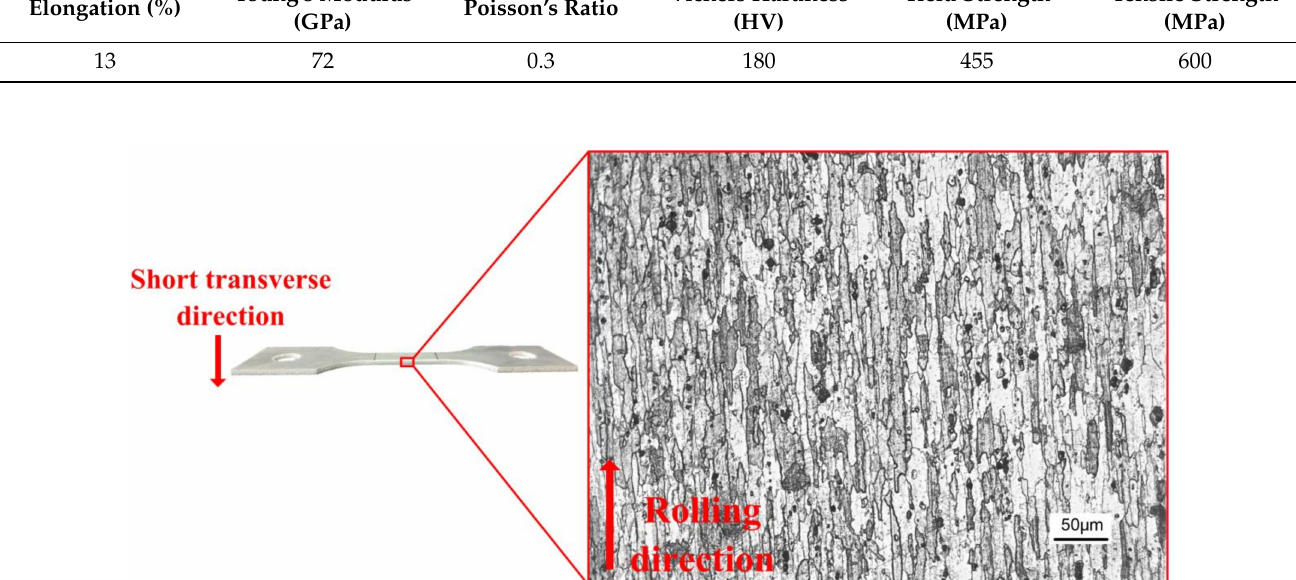
Figure 1. Short transverse microstructure of 7075 aluminum alloy.